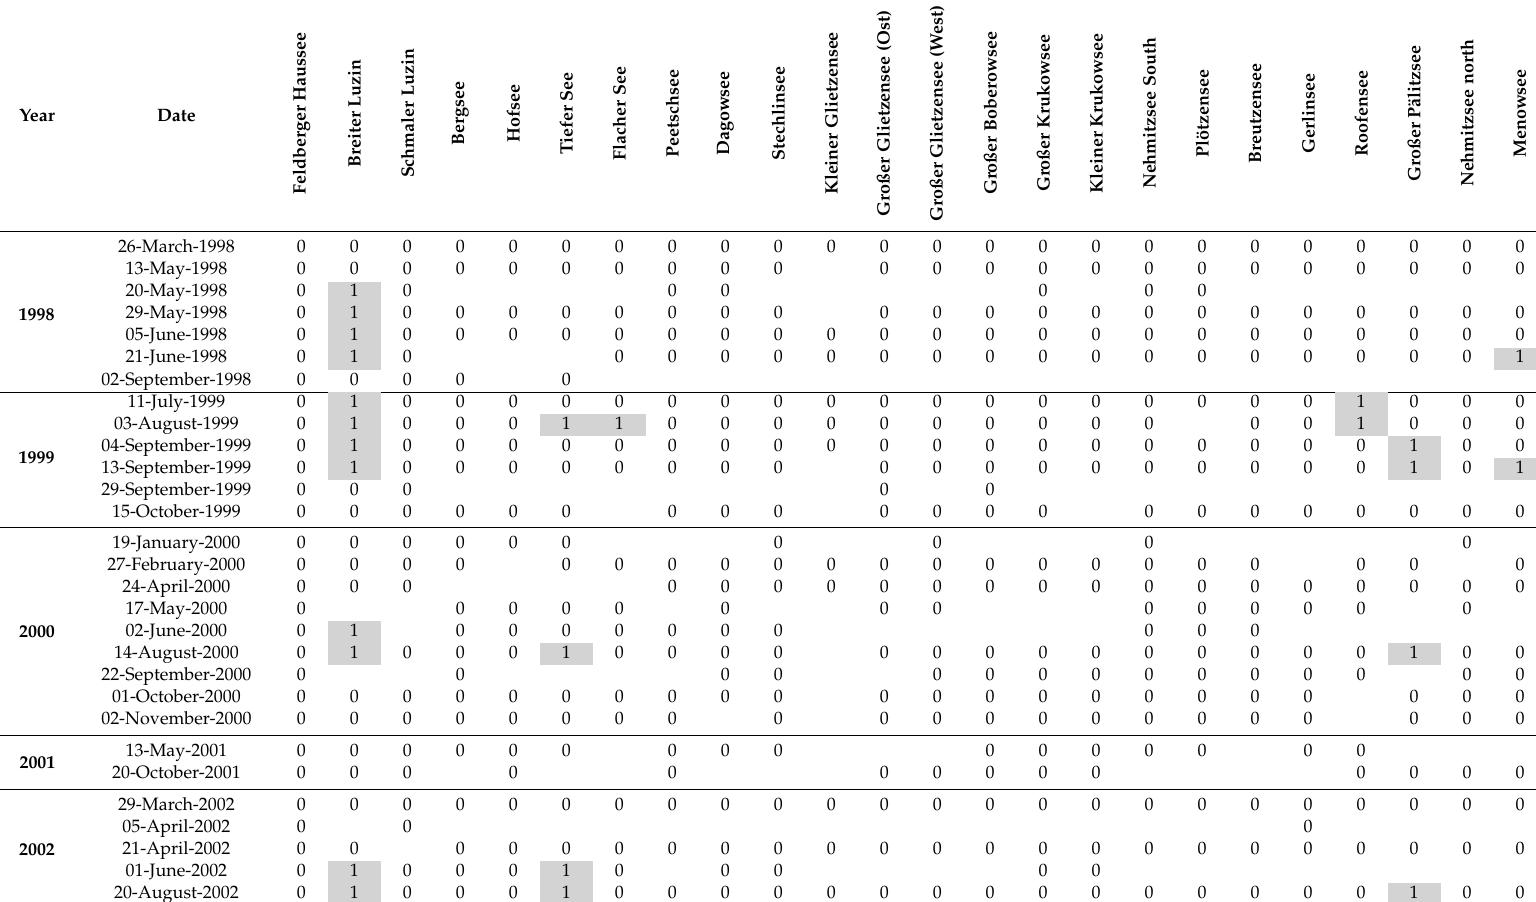
Table A1. Calcite precipitation based on the Landsat time series (1998–2015) using the threshold of the area BGR. Lakes with calcite precipitation events are marked with “1” and highlighted in gray. Dark lakes without calcite precipitation are marked with “0”. Blank cells are the dates without